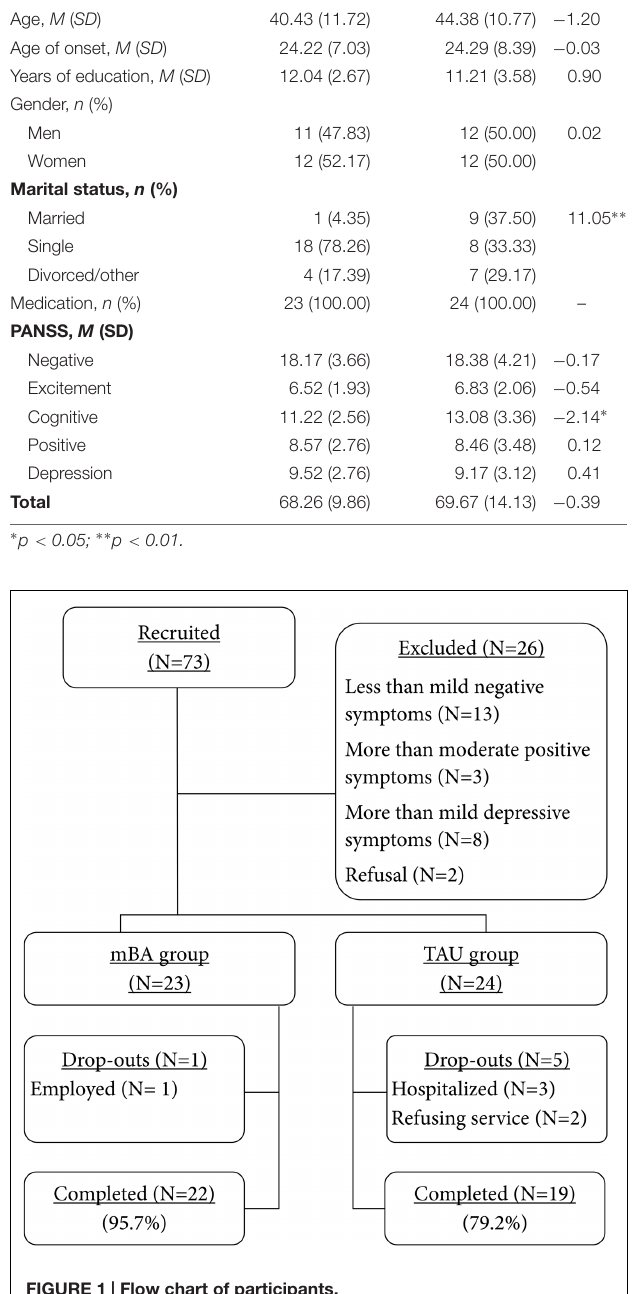
FIGURE 1 | Flow chart of